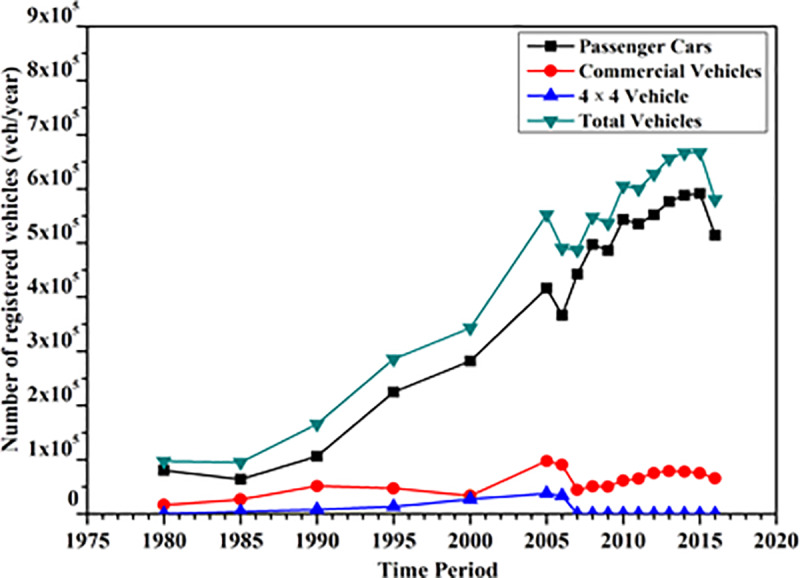
The number of vehicles registered from 1980 to 2016 [10].